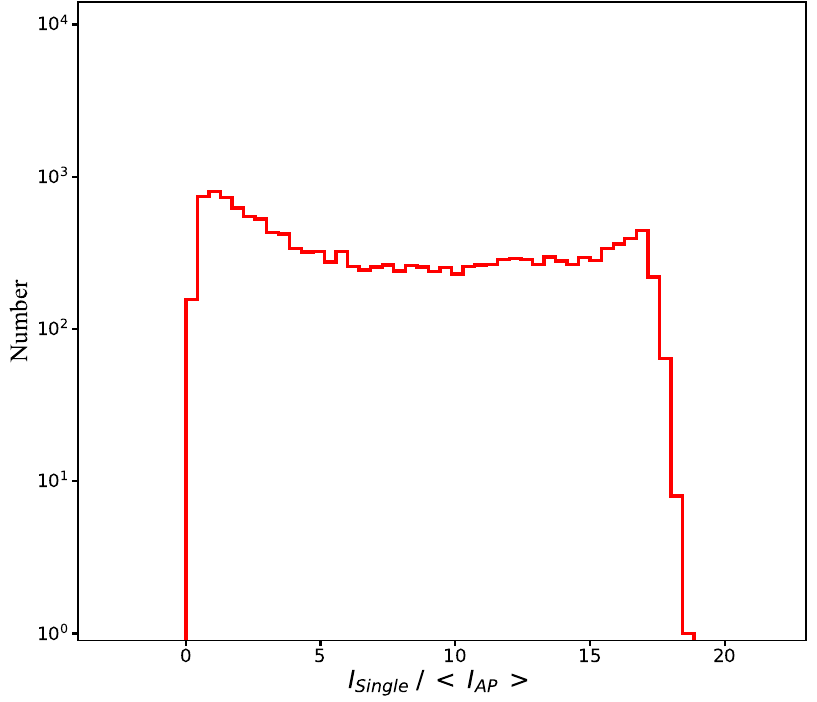
Figure 3. The distribution histogram of the pulse peak flux density. The peak flux density of each single-pulse ( I Single ) was normalized by the peak flux density of the average pulse profile ( I AP